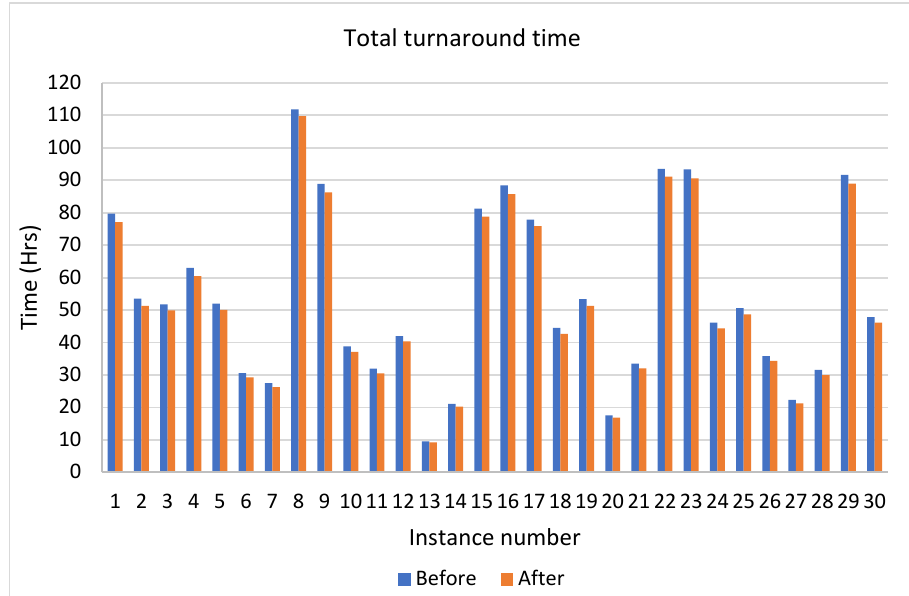
Figure 18. The change in the delivery cost before and after leveling the workload.